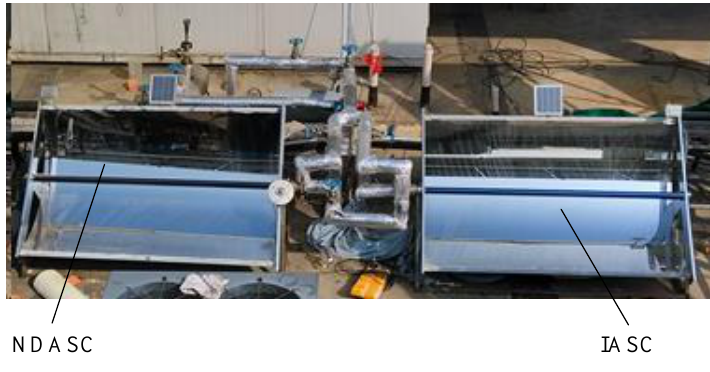
Figure 10. Photos of the experimental setups of the NDASC and the